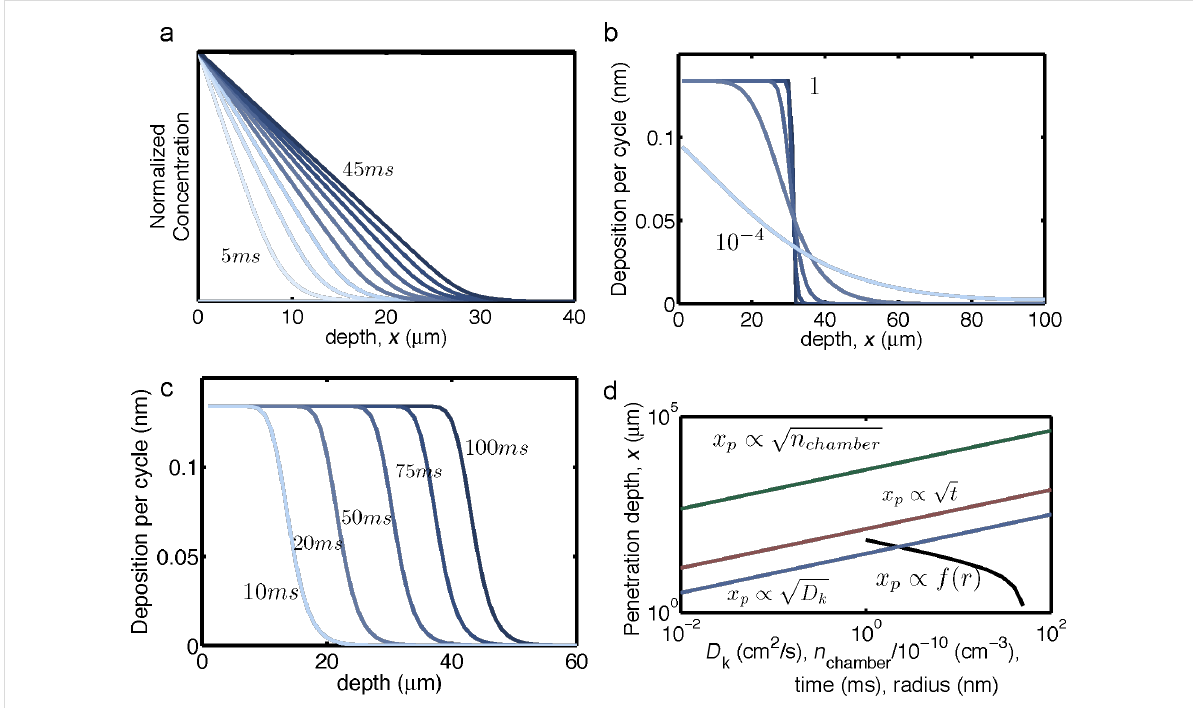
Figure 3: Results of the precursor adsorption kinetics simulation while using the parameters defined in Table 1. The concentration of precursor mole- cules as a function of depth at several time steps (0 to 50 ms, with 5 ms intervals) within the CNT array is plotted in (a). The effect of the reactive sticking coefficient is demonstrated in (b), where the deposited oxide thickness per cycle is plotted versus the depth in the array, after 50 ms expo- sure. In (c) the effect of the precursor exposure time is plotted. In (d), the penetration depth of the oxide is plotted as a function of the precursor concentration, exposure time, Knudsen diffusion coefficient, and radius of the CNTs with a reactive sticking coefficient of 10 − 2 . The penetration depth clearly depends on the square root of the precursor concentration, exposure time, and diffusion coefficient, but has a nontrivial dependence on the radius of the